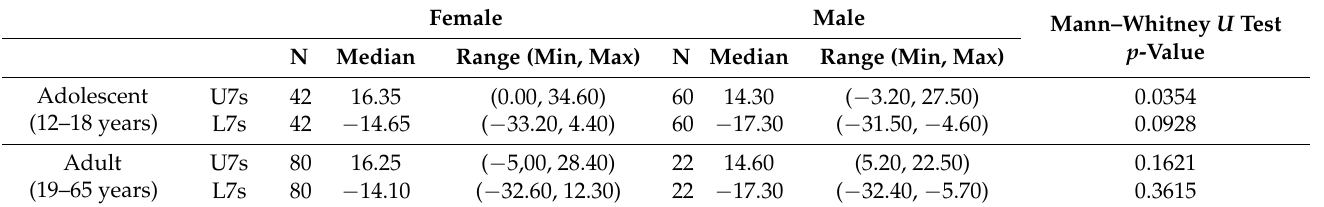
Table 2. The comparison of the second molar inclination between genders. U7s: maxillary second molars; L7s: mandibular second molars.